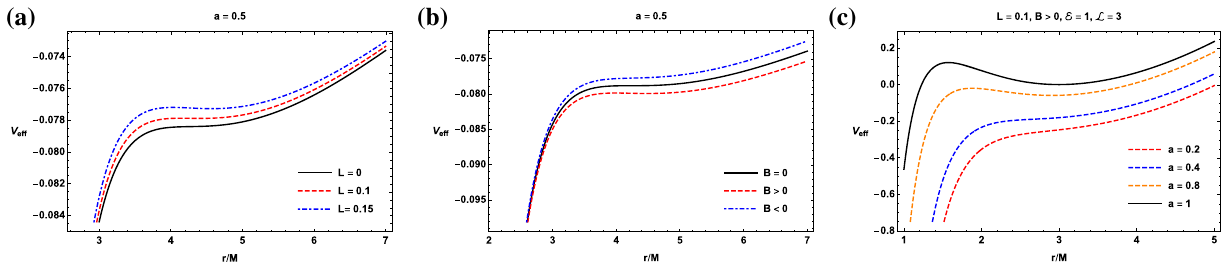
netic field, b. in the presence of external magnetic field when L = 0 . 05 and c. in the presence of both parameters. Units in which M =